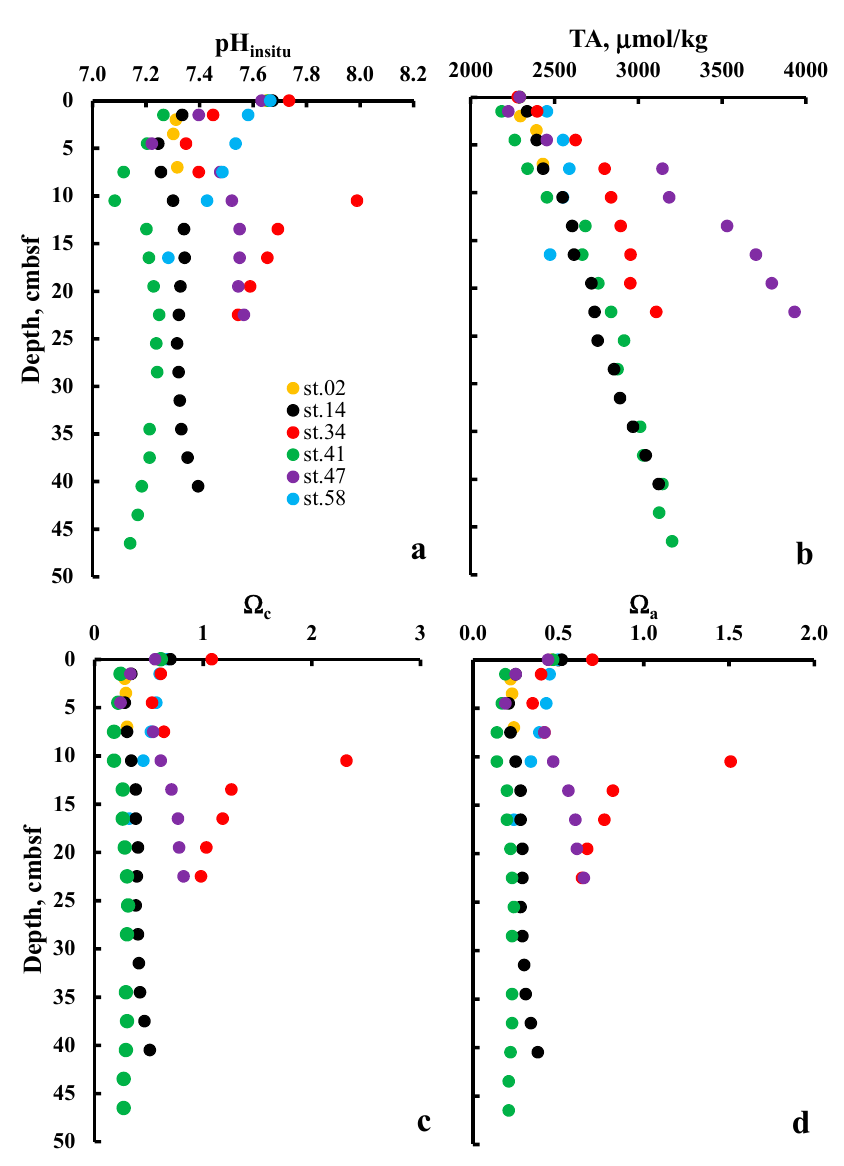
Figure 6. Vertical distributions of the carbonate system parameters for sediments: ( a )—pH in situ (total hydrogen concentration scale, [51]); ( b )—total alkalinity; ( c )—saturation degree indices of calcite; ( d )—saturation degree indices of aragonite.